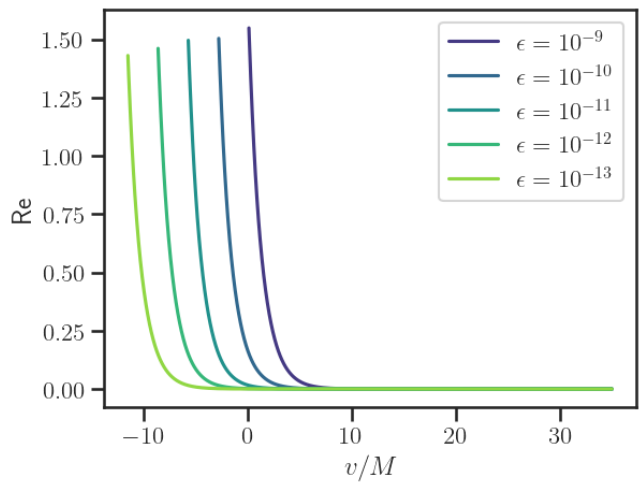
Figure 9 . Evolution of the Reynolds number defined in eq. (6.2) for different perturbative scales (cid:15) . In all cases we see that the Reynolds number becomes larger than 1 before we stop the evolution.